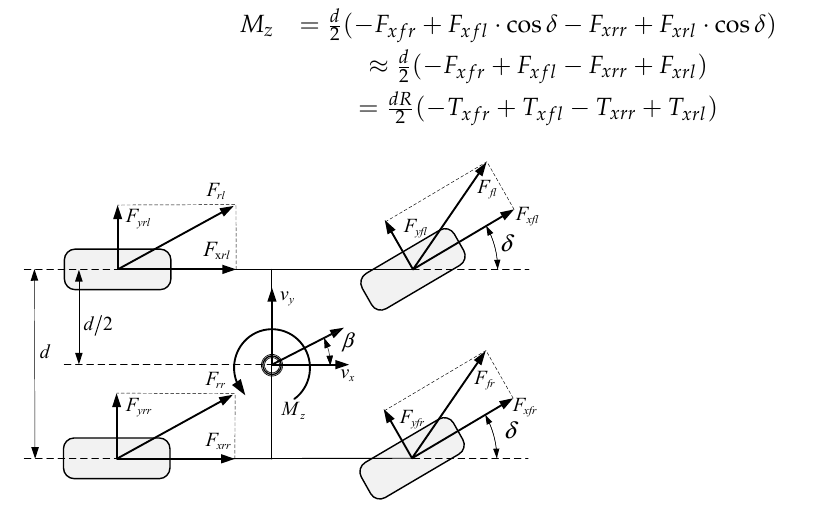
β The front-wheel steering angle has a great influence on the change of - r phase portrait. Figures 4 and 5 show the phase portrait based on Equation (8) of the sideslip angle and yaw rate with different steering angles: 0 rad, 0.1 rad, 0.25 rad, 0.35 rad. The fixed points marked as blue or red can be directly found in Figure 4, respectively, the blue point represents the stable equilibrium point that the domain around which is convergent, and the red points are saddle points showing bifurcation behavior, which can be regarded as the boundary points between stable region ③ and unstable region ① and ② depicted in the streamline of a different color. For searching the motion law of the fixed points, we set the derivatives of the sideslip angle and yaw rate to zero and decouple the  expression with β and r  , then we can obtain (10):